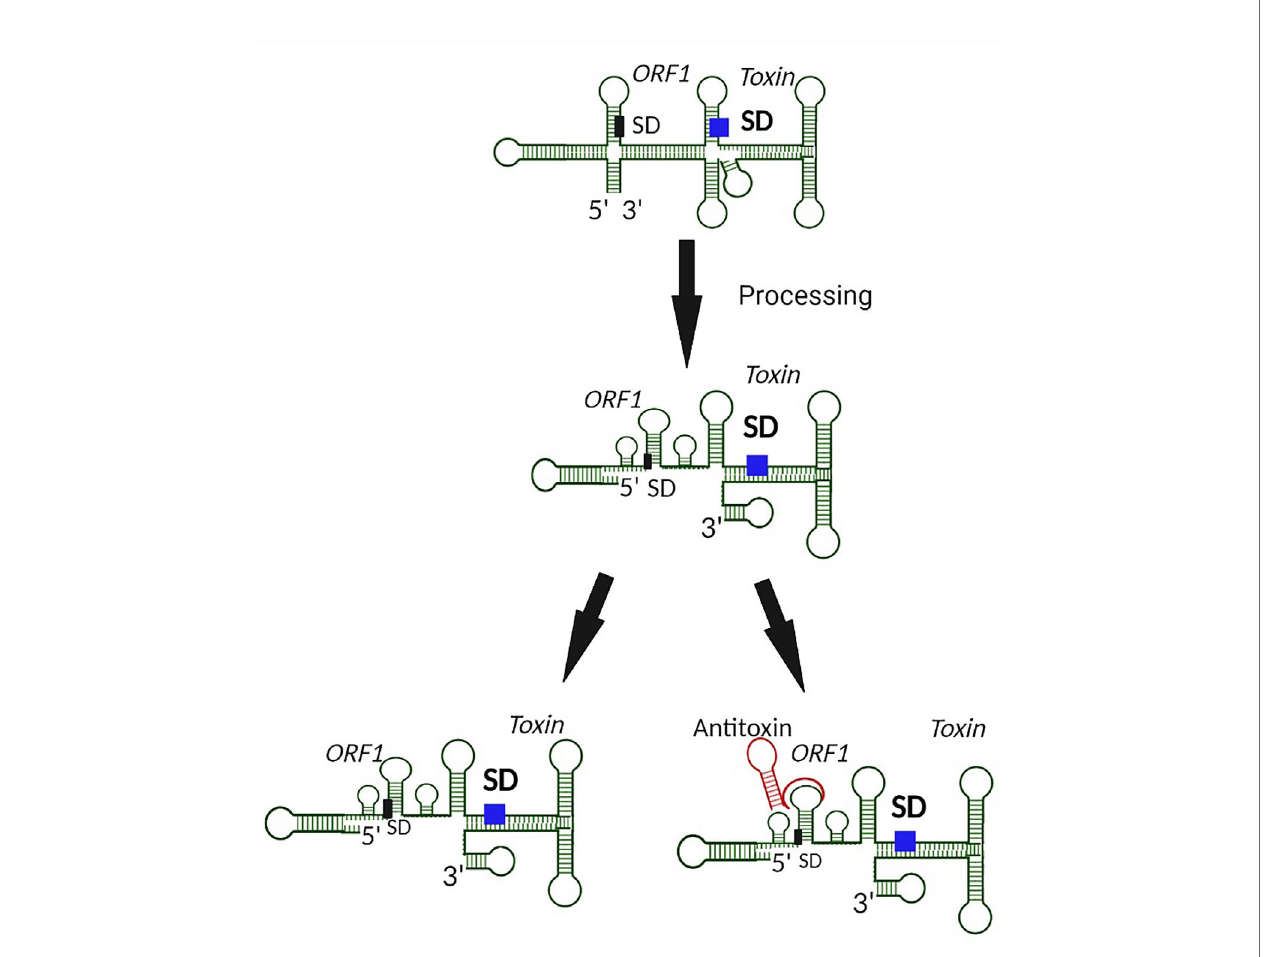
FIGURE 2 | Prevention of Type I toxin production by blocking of an upstream coupled open reading frame by the antitoxin. In the case where translation of a toxin is coupled to translation of an upstream open reading frame (ORF1), binding of the antitoxin to the upstream SD prevents translation from both open reading frames, including from that encoded Type I